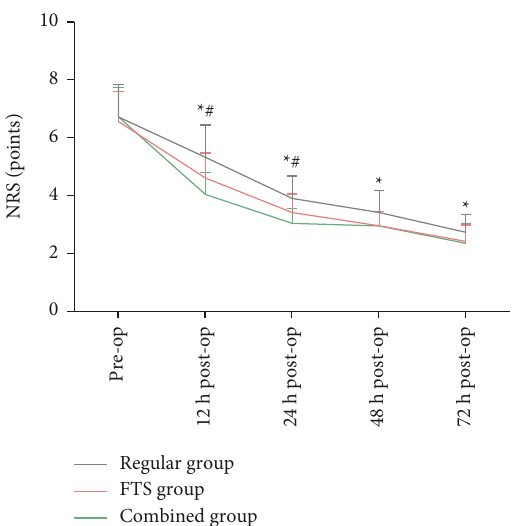
Figure 2: Comparison of pain scores at different times among the three groups. Note . Comparison with the regular group, ∗ P < 0 . 05. Comparison with the FTS group, # P < 0 .